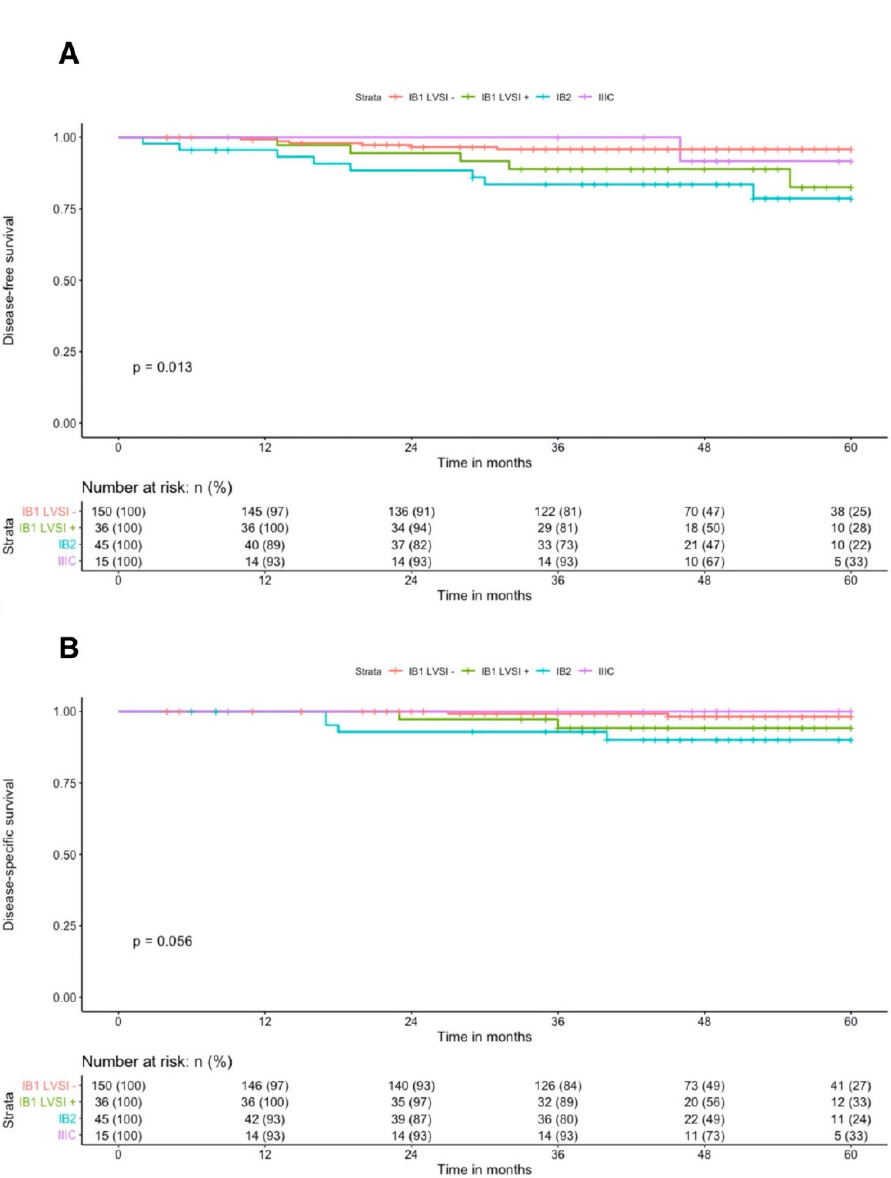
Figure 2. Kaplan-Meier 5-year disease-free survival ( A ) and 5-year disease-specific survival ( B ) curves according to 2018 FIGO classification.